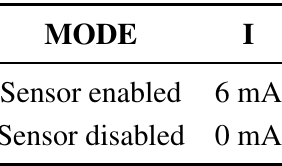
Table 3. Sensor current